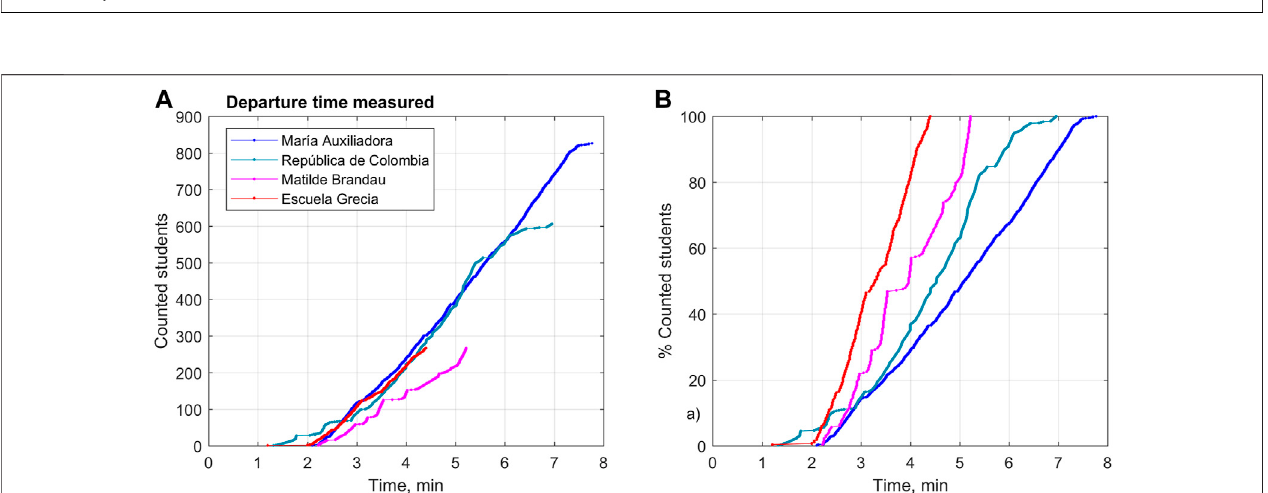
FIGURE 2 | Gradients of the evacuation routes of the four examined schools.